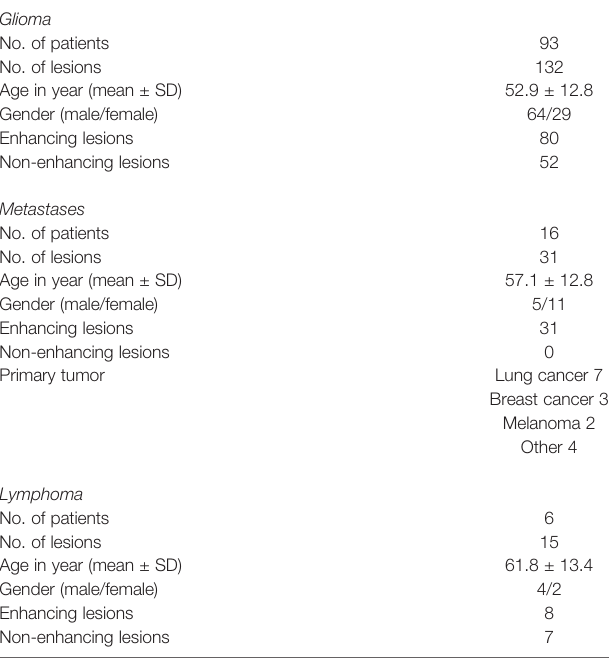
TABLE 1 | Patient